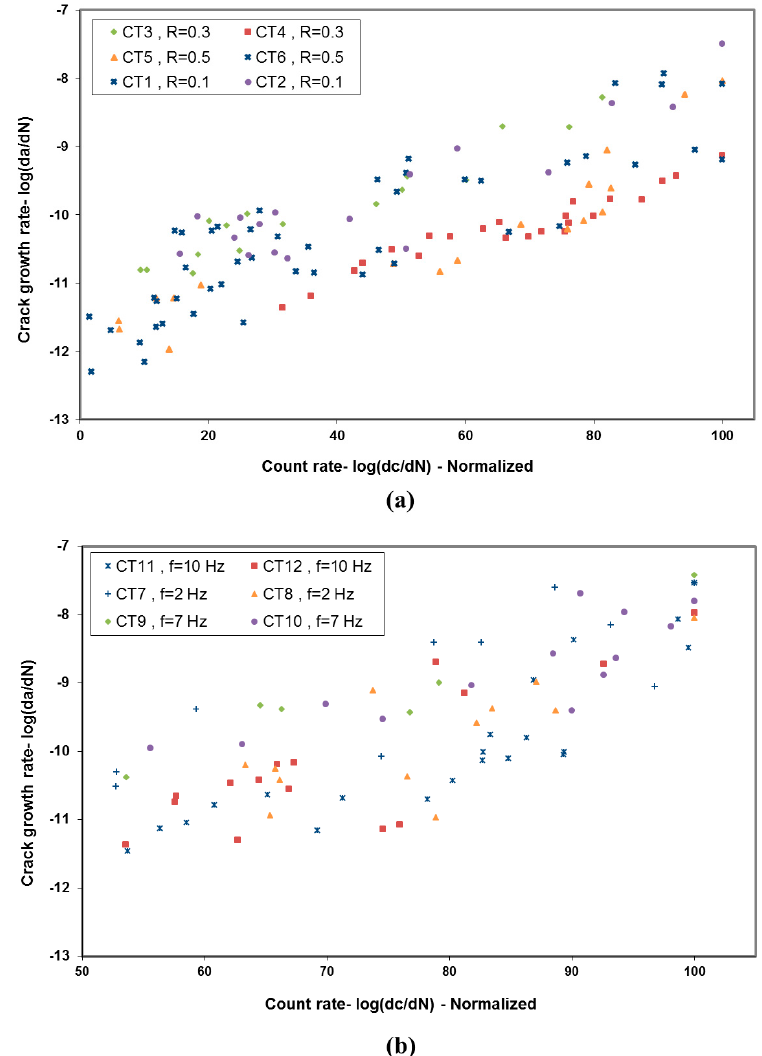
Figure 5. Crack growth rate versus AE count rate for Al7075-T6 tests at ( a ) different loading ratios; ( b ) different loading frequencies—log scale. The base scale of da / dN is in/cycle.